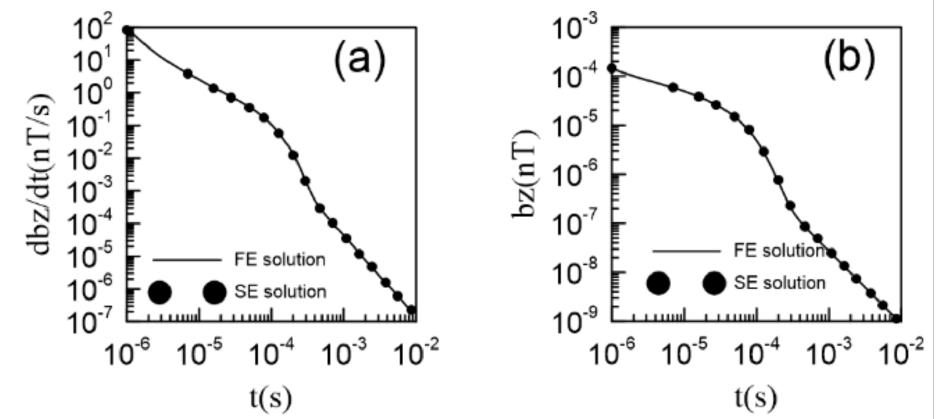
Figure 6. Comparison of ( a ) dbz/dt and ( b ) bz responses calculated by our SETD method with those calculated by FE method based on unstructured grids for the horizontal plate model in Figure